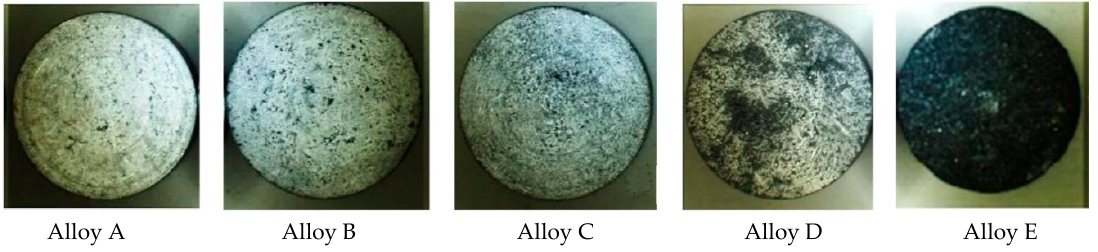
Figure 10. Corrosion characteristics of the tested alloys after the Audi test.